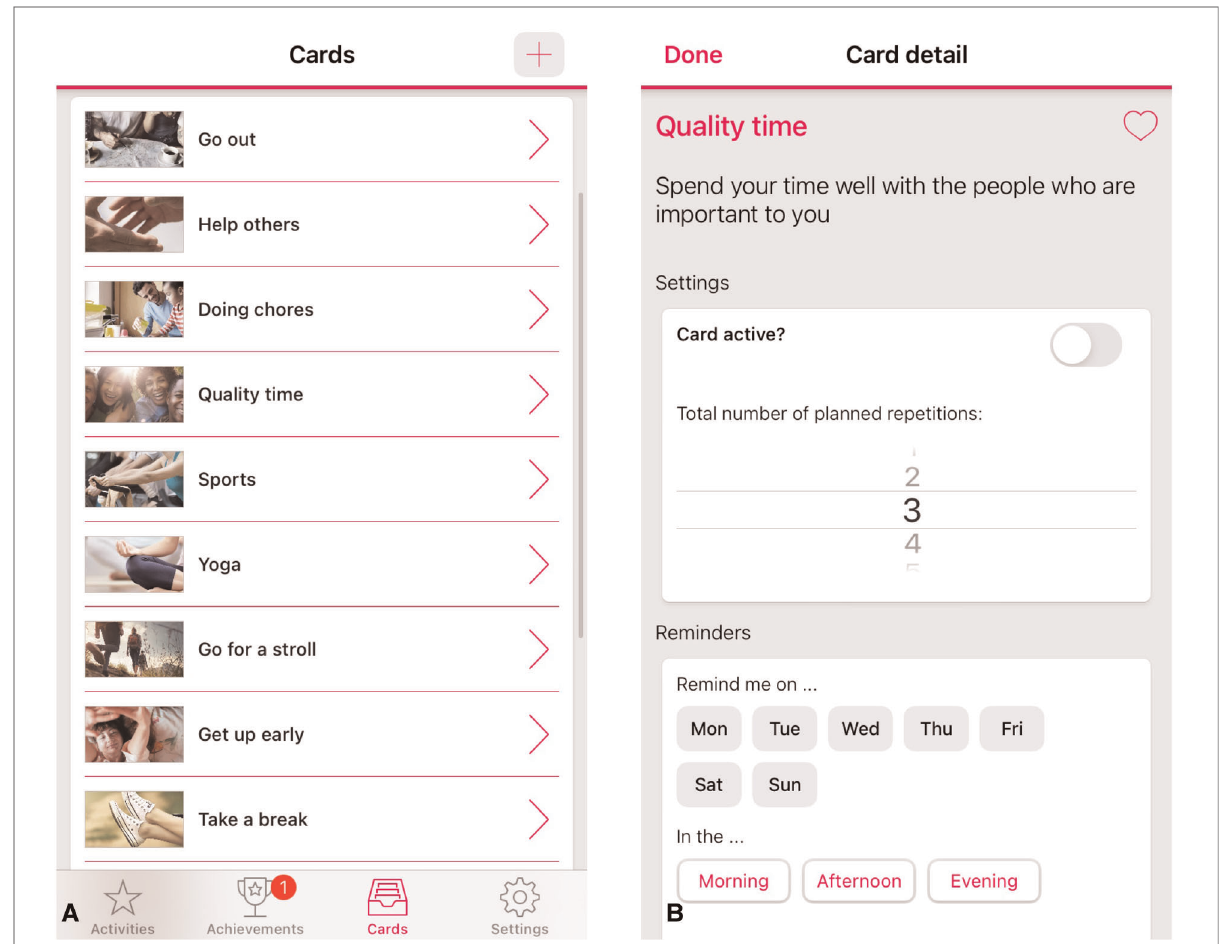
FIGURE 1 Screenshots of the eMovit app, showing positive activities ( A ), personalisation option of activities ( B ). Note. The eMovit app was developed by Brigth fi sh BV for VU Amsterdam. © 2022 VU Amsterdam. All rights